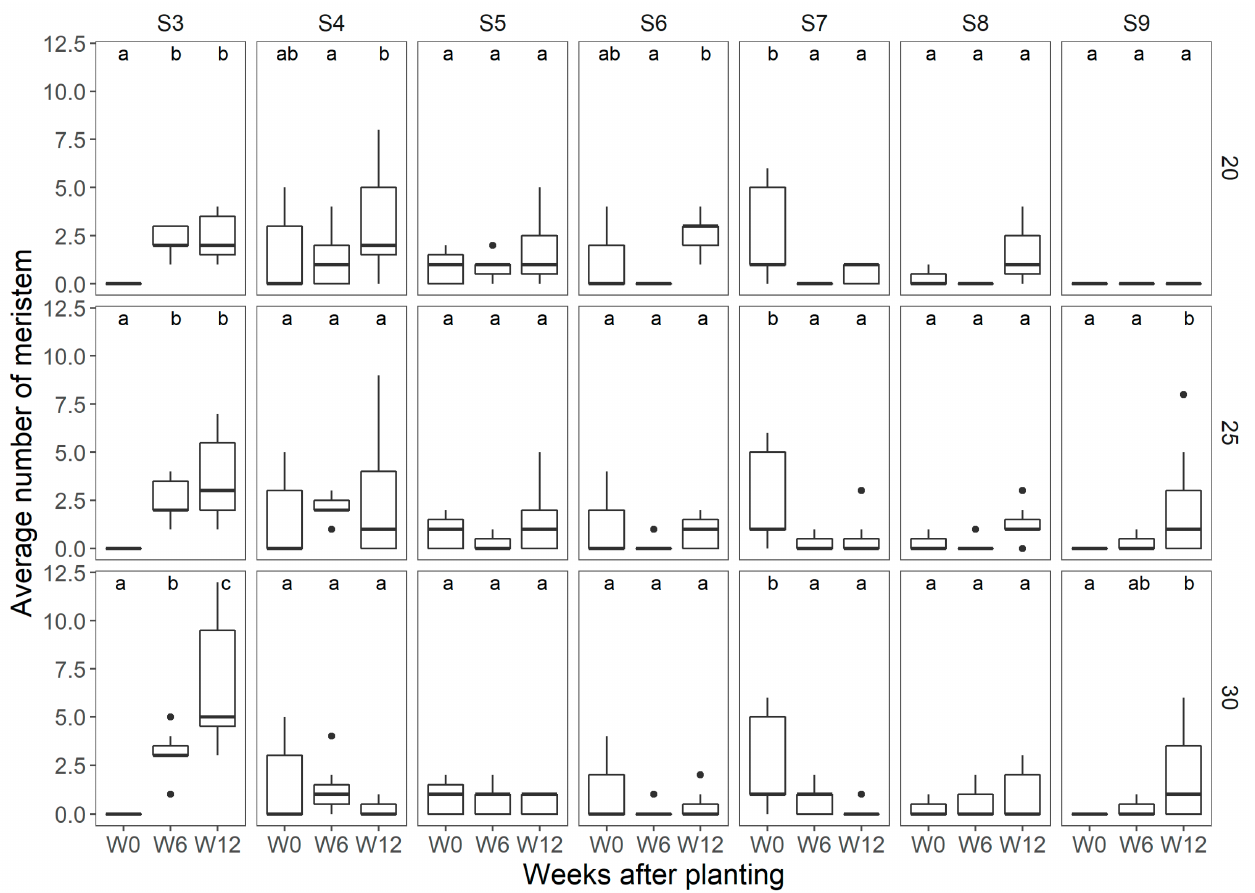
Figure 4. Average number of meristems observed per temperature treatment at each of the flower mapping occasions for ‘Favori’, where W0 = week 0, W6 = week 6, and W12 = week 12 after start of treatment, at 20 ◦ C 25 ◦ C, and 30 ◦ C, N = 7. The different letters above the boxplots in each box denote differences among means between the flower mapping occasions per temperature treatment and similar lowercase letters indicate non-significant difference by the Holm − Sidak post-hoc at 5% of error probability ( p <